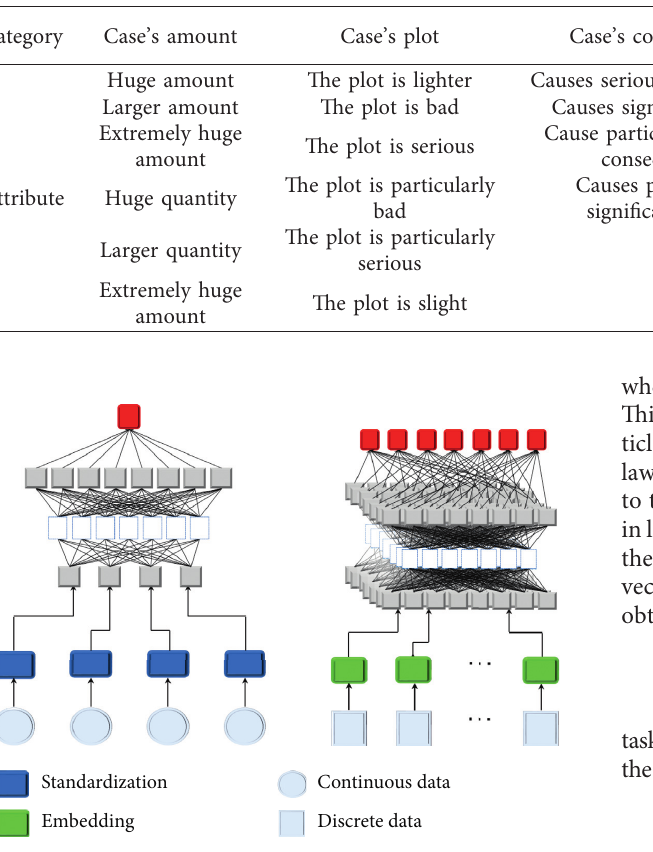
Table 3: Discrete data.